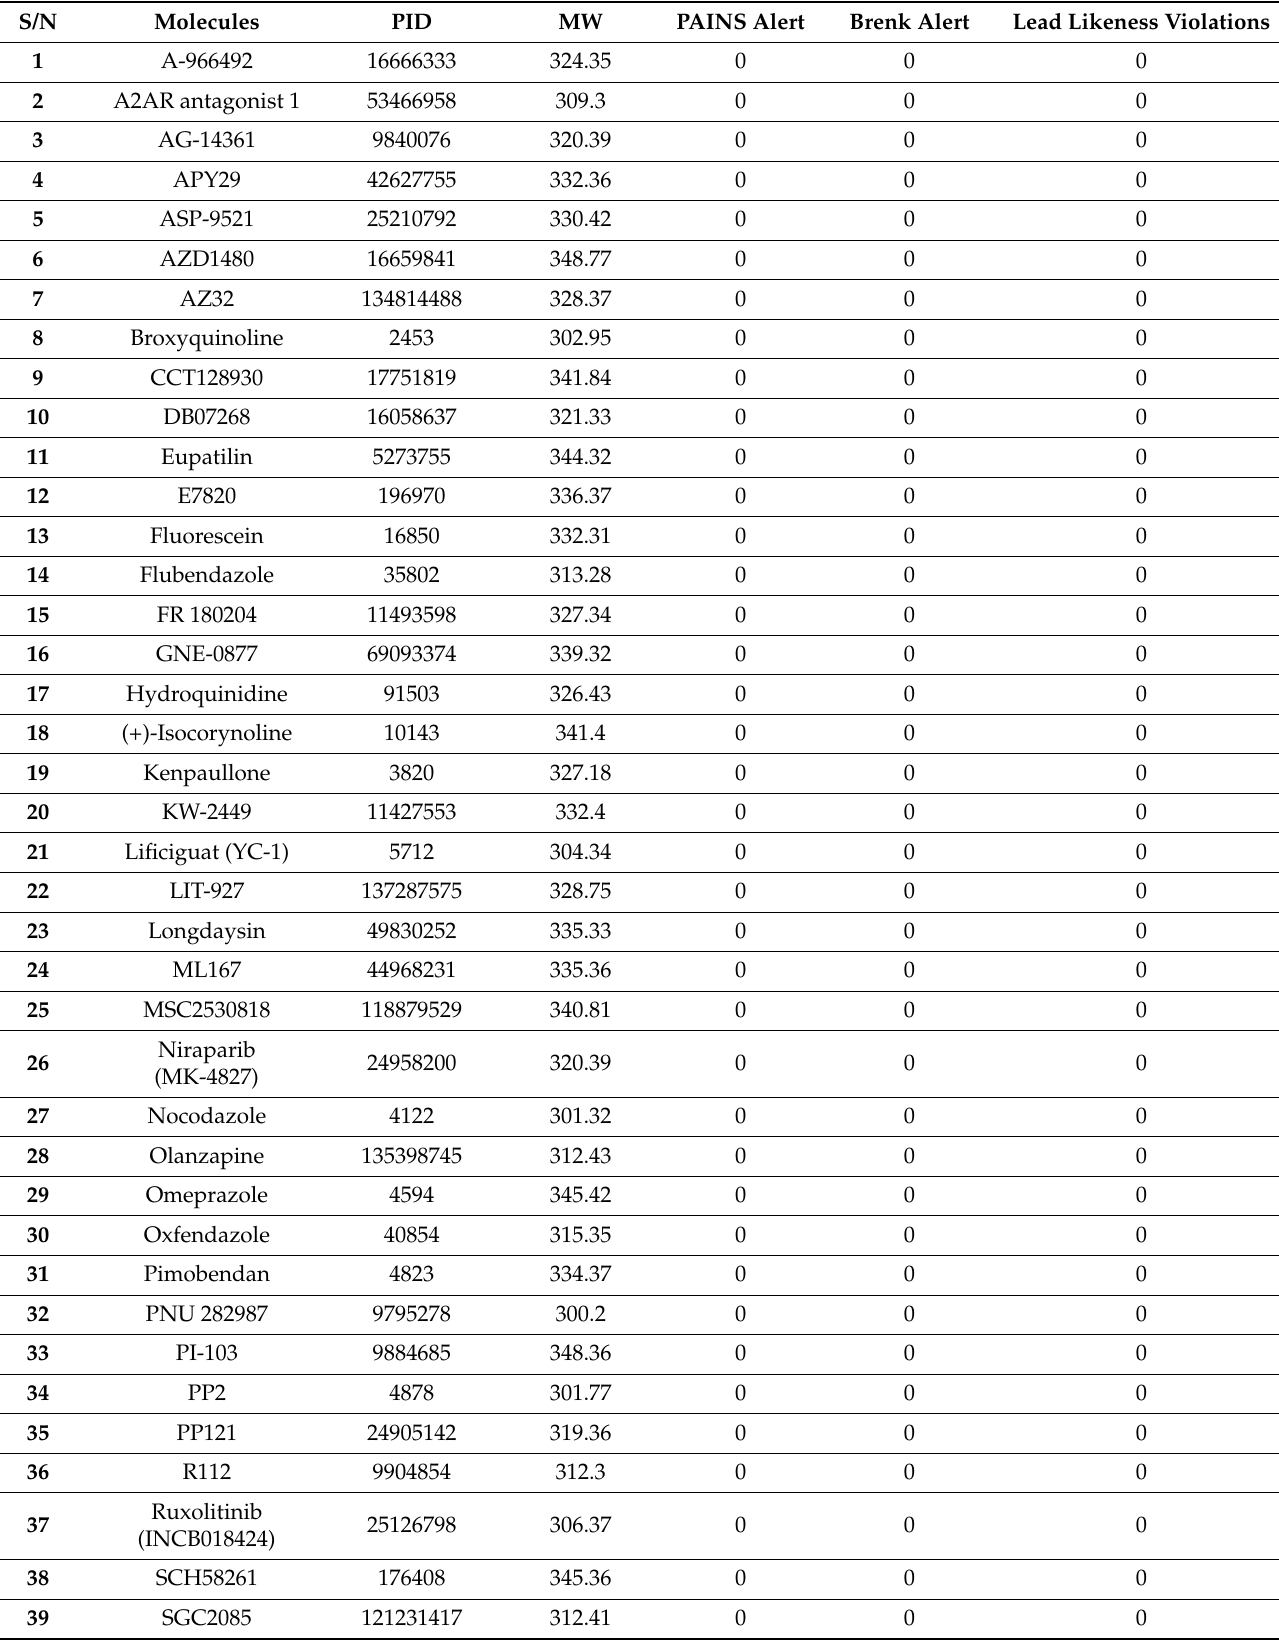
Table 1. Screened Molecules from selleckchemical’s unique library of anti-cancer